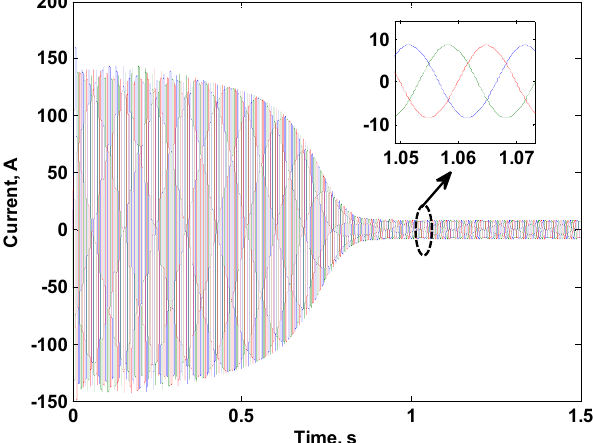
Figure 20. Three-Phase Motor Currents when Excited with 220 V, 50 Hz.